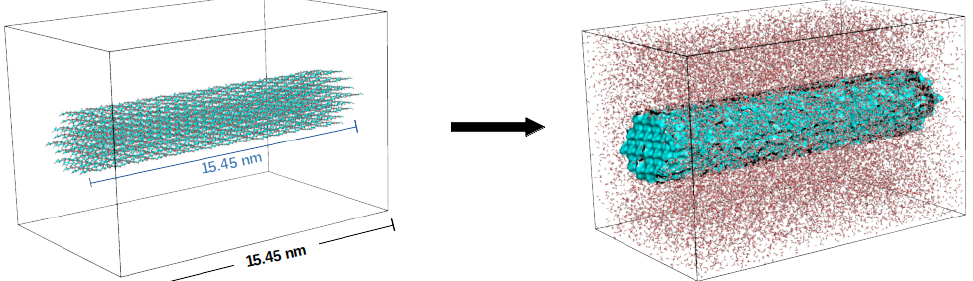
Figure 3. Illustration of the CNF segment in a unit cell before ( left ) and after being solvated in water ( right ). Each molecular chain of the nanofibril comprises 30 cellulose monomers. The unit cell dimensions are chosen to fit a ratio of 30% cellulose by molecular weight. The z -axis length is fitted to the fibril length to allow the linking of monomers across the periodic cell, mimicking an infinite fibril.